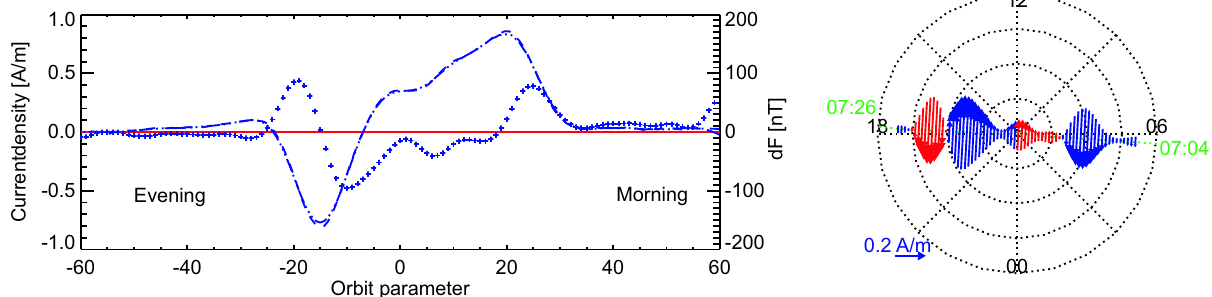
Fig. 1. Left: (Orsted orbit 9015, north) This figure illustrates the results of the current derivation technique applied to a single north polar crossing of the Ørsted satellite starting around 07:00 UT on 10 November 2000. Plotted are the measured and modeled field strength deviations (right scale and dotted and dashed curves, respectively), together with the modeled current density (crosses at the position of the individual line currents with positive currents defined as moving from right to left, as seen from the satellite flying from morning to evening). These are plotted as functions of orbit parameter. Right: On a polar map of the northern high latitude ionosphere, the derived line current densities are plotted as vectors perpendicular to the orbit track (the assumed direction of the modeled line currents). The size of each vector indicates the strength of the current density. Red color indicates mostly eastward directed vectors and blue color mostly westward directed vectors. Note, that with this definition, the color or arrows changes near the pole, while the actual direction is unchanged. The map is in Apex, MLT coordinates, with noon at the top and dusk to the left. Each latitude circle is 10 ◦ . The numbers in green mark the begin and end UT times for the